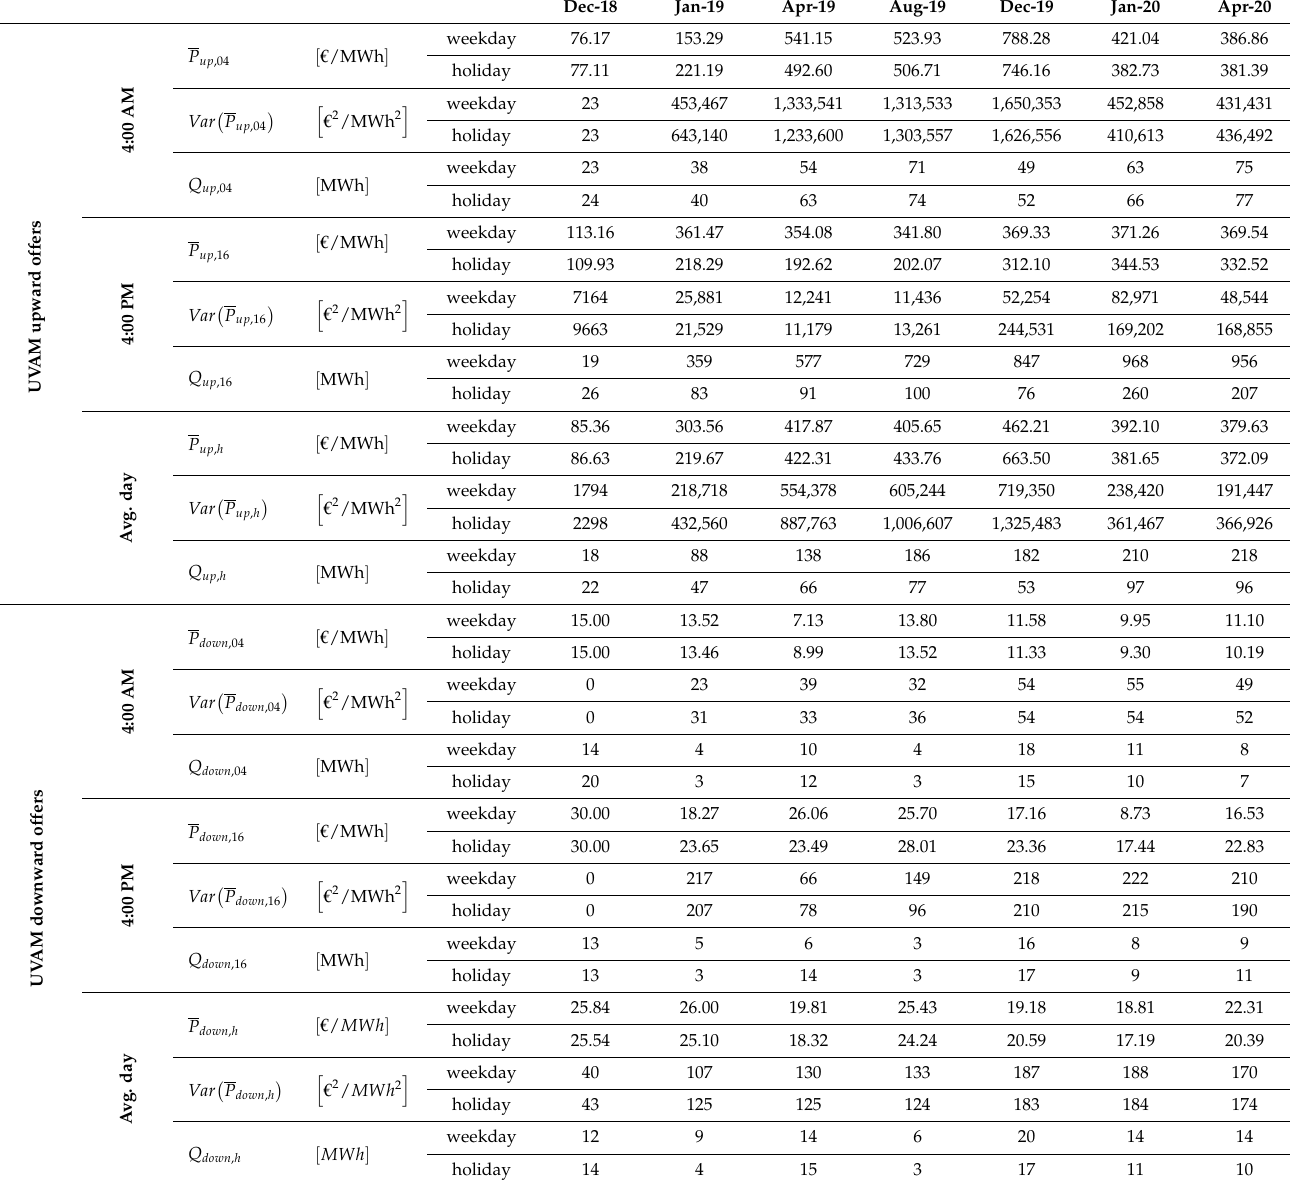
Table A1. Additional statistics on hourly upward and downward bids of aggregated units for selected